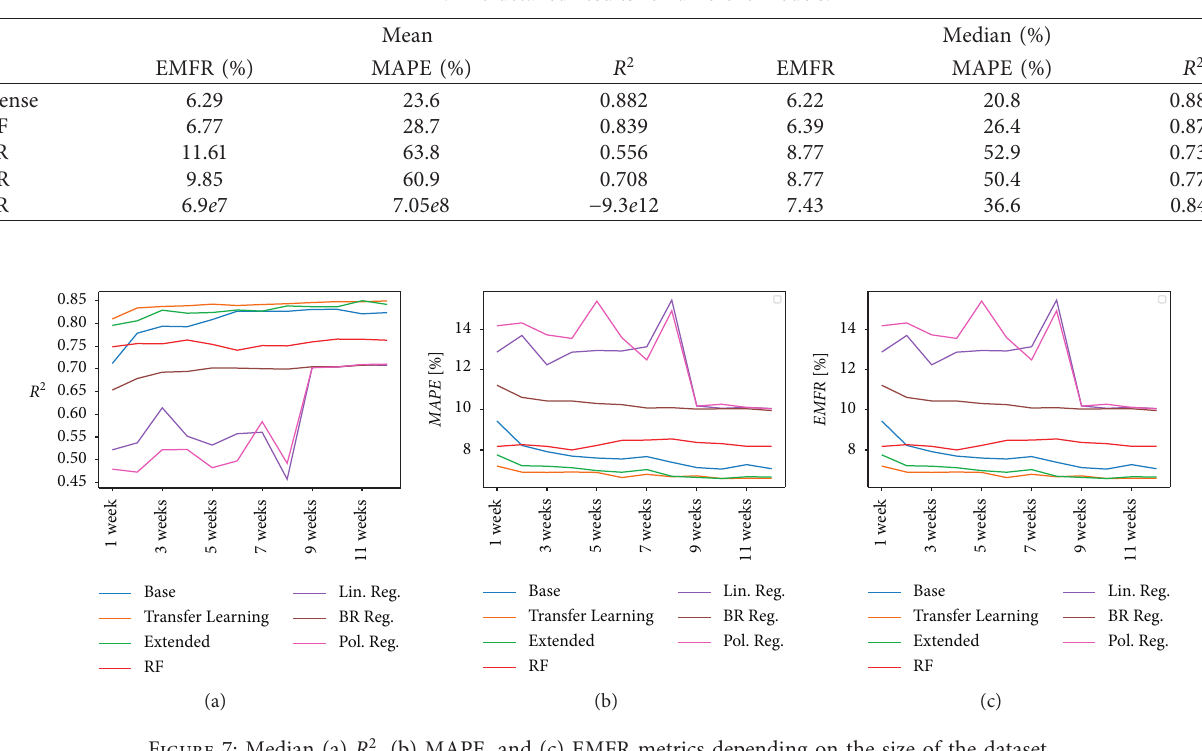
Table 4: The detailed results for different models.